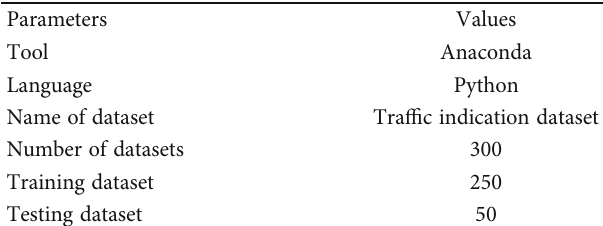
Table 1: Evolution of